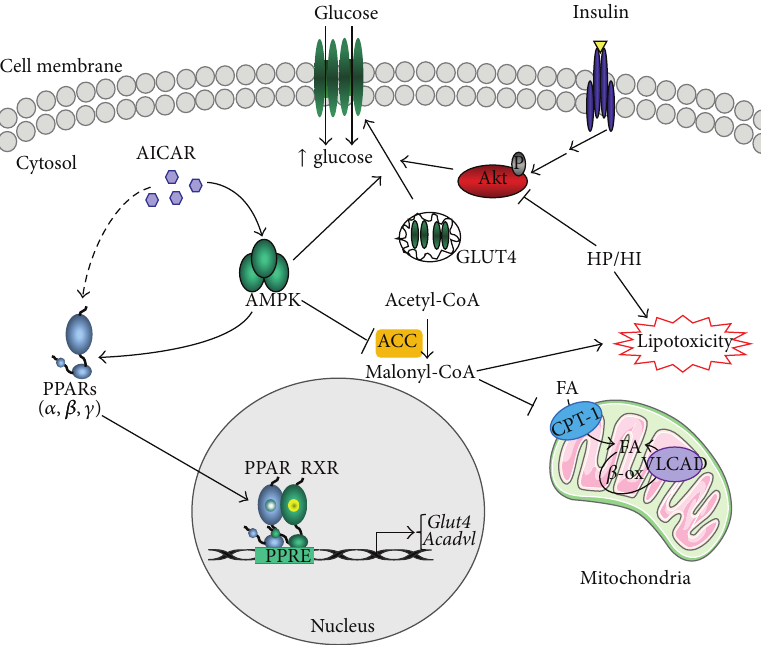
Figure 6: Schematic representation of the potential mechanisms by which AICAR regulates cardiac metabolism and protects HL-1 cardiomyocytes from the HP/HI-induced lipotoxicity and insulin resistance. HP/HI stimulation induces insulin resistance by promoting the intramyocellular lipid build-up, which in turn inhibits the insulin signalling pathway and the AKT-mediated GLUT4 membrane translocation and glucose uptake. AICAR treatment takes part in the regulation of the cardiac metabolic adaptation at several levels. First, AICAR short- term stimulation promotes the inhibition of ACC, thereby reducing the levels of the allosteric inhibitor of CPT-1 malonyl-CoA and regulating the fatty acid mitochondrial 𝛽 -oxidation. In addition, AICAR-induced AMPK activation promotes GLUT4 membrane translocation through non-insulin dependent mechanisms. Finally, AICAR stimulation induces the three PPARs mRNA levels and controls the expression of some key PPAR-target genes, such as Acadvl and Glut4 , involved in both glucose and fatty acid cardiac metabolism. Therefore, through these different mechanisms, AICAR is able to regulate both the acute metabolic response and the long-term metabolic adaptation in cardiac